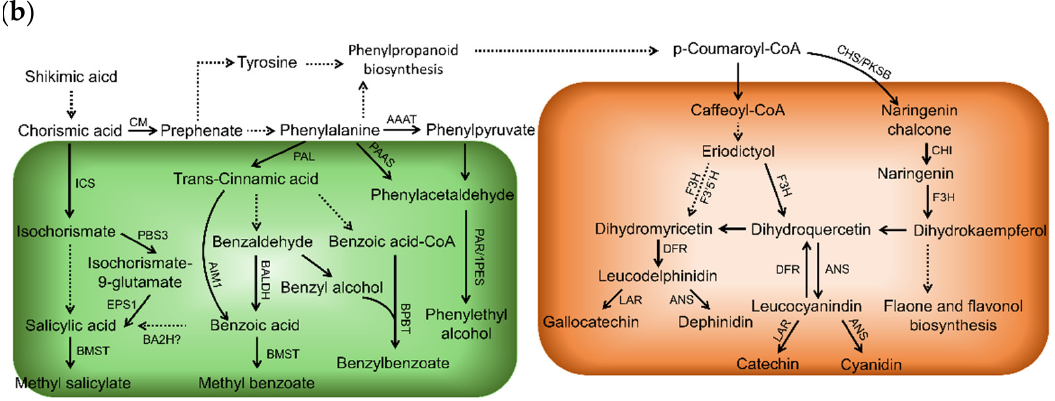
Figure 1. Biosynthetic pathways of the main quality components in tea. The biosynthetic pathways of theanine, caffeine, green leaf volatiles (GLV), volatile terpenes (VT), and carotenoids ( a ), and the biosynthetic pathways of volatile phenylpropanoids/benzenoids (VPBs) and catechins ( b ). AAAT, aromatic amino acid aminotransferases; ACAT, Acetoacetyl-CoA; ADC, arginine decarboxylase; ADH, Alcohol dehydrogenase; AIM1, abnormal inflorescence meristem1; ANR, anthocyanidin reductase; ANS, anthocyanidin synthase; BA2H, benzoic acid 2-hydroxylase; BALDH, benzaldehyde dehydrogenase; BMST, salicylic acid carboxyl methyltransferase; BPBT, benzoyl-CoA:benzylalcohol/2-phenylethanol benzoyl transferase; CHI, chalcone isomerase; CHS, chalcone synthase; CM, chorismate mutase; DFR, dihydroflavonol 4-reductase; DXR, 1-deoxy-D-xylulose 5-phosphate reductoisomerase; DXS, 1-deoxy-D-xylulose-5-phosphate synthase; EPS1, ENHANCED PSEUDOMONAS SUSCEPTIBILITY 1; FDPS, farnesyl diphosphate synthase; F3H, flavanone-3-hydroxylase; F3 ′ 5 ′ H, flavonoid 3 ′ ,5 ′ -hydroxylase; GGPPS, geranylgeranyl pyrophosphate synthase; GOGAT, glutamate synthase; GS, glutamine synthetase; HMGR, 3-hydroxy-3-methylglutaryl-coenzyme A reductase; HMGS, hydroxymethyl glutaryl-CoA synthase; HPL, hydroperoxide lyase; ICS, isochorismate synthase; IDI, isopentenyl-diphosphate Delta-isomerase; LAR, leucoanthocyanidin reductase; LOX, lipoxygenase; LYC, lycopene beta cyclase; MXMT, theobromine synthase; PAAS, phenylacetaldehyde synthase; PAL, phenylalanine ammonia lyase; PAR, phenylacetaldehyde reductase; PBS3, avrPphB SUSCEPTIBLE3; PDS, phytoene desaturase; PSY, phytoene synthase; SCPL1A, type 1A serine carboxypeptidase-like acyltransferases; TCS, caffeine synthase; TS, Theanine synthase; XMT, 7-methylxanthosine syn- thase; ZDS, carotene desaturase; 1PES, 1-Phenylethanol synthetase. Green represents the metabolic pathways of volatile components, while brown represents the metabolic pathways of non-volatile quality